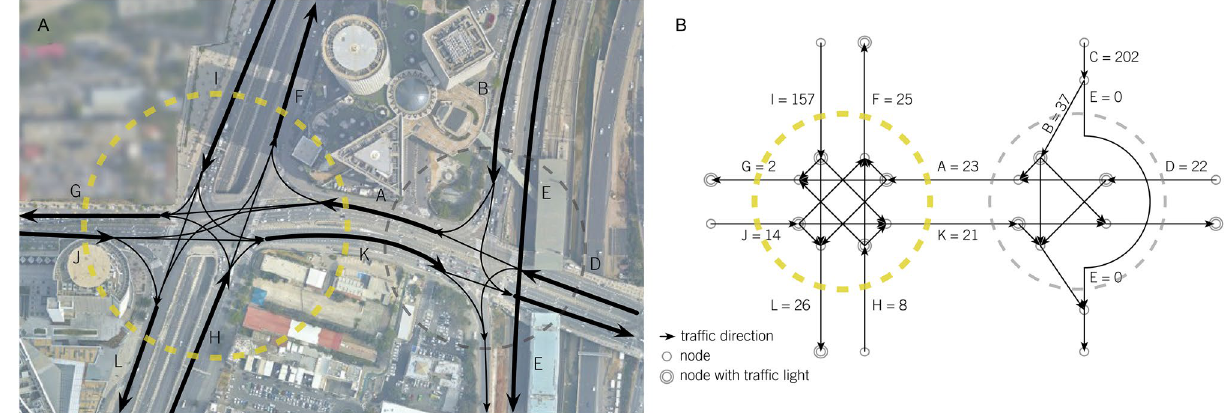
Figure 4. HaShalom Interchange on March 21st, 2018 at 8:45 am. ( A ) Aerial photo of the roads; ( B ) topological representation of the roads network, where the nodes represent junctions (with or without traffic lights), the links represent the road segments, and the weight of the links represents their CumulativeCost ( t ) JT (in VH units) from the time they became congested until 8:45 am. The areal photo was obtained from the Tel Aviv municipality GIS website: (https:// gisn. tel- aviv. gov. il/ iview 2js4/ index.